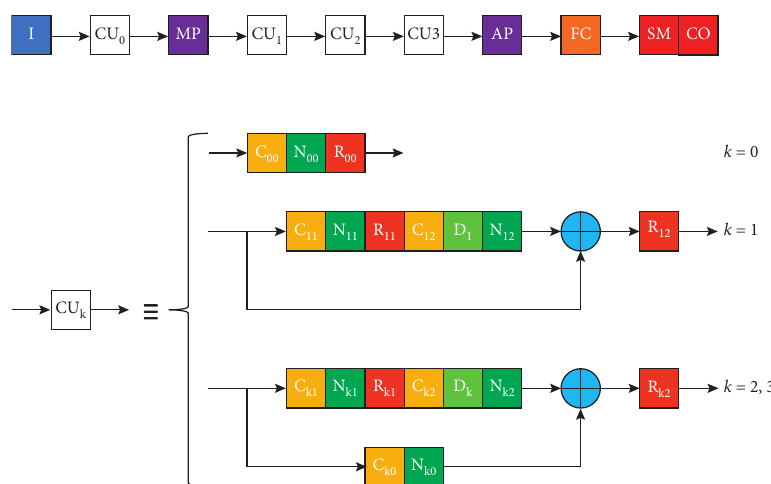
Figure 2: CNN architecture, where I is the image input layer; CU th convolutional unit; MP and AP are the max pooling and average k is the k pooling layers, respectively; FC is the fully connected layer; and SM and CO are the SoftMax and classification output layer, respectively. In the k th convolutional unit, C kj , N kj , R kj , and D k are the j th convolutional layer, the j th batch normalization layer, the j th ReLu layer, and the dropout layer, respectively.